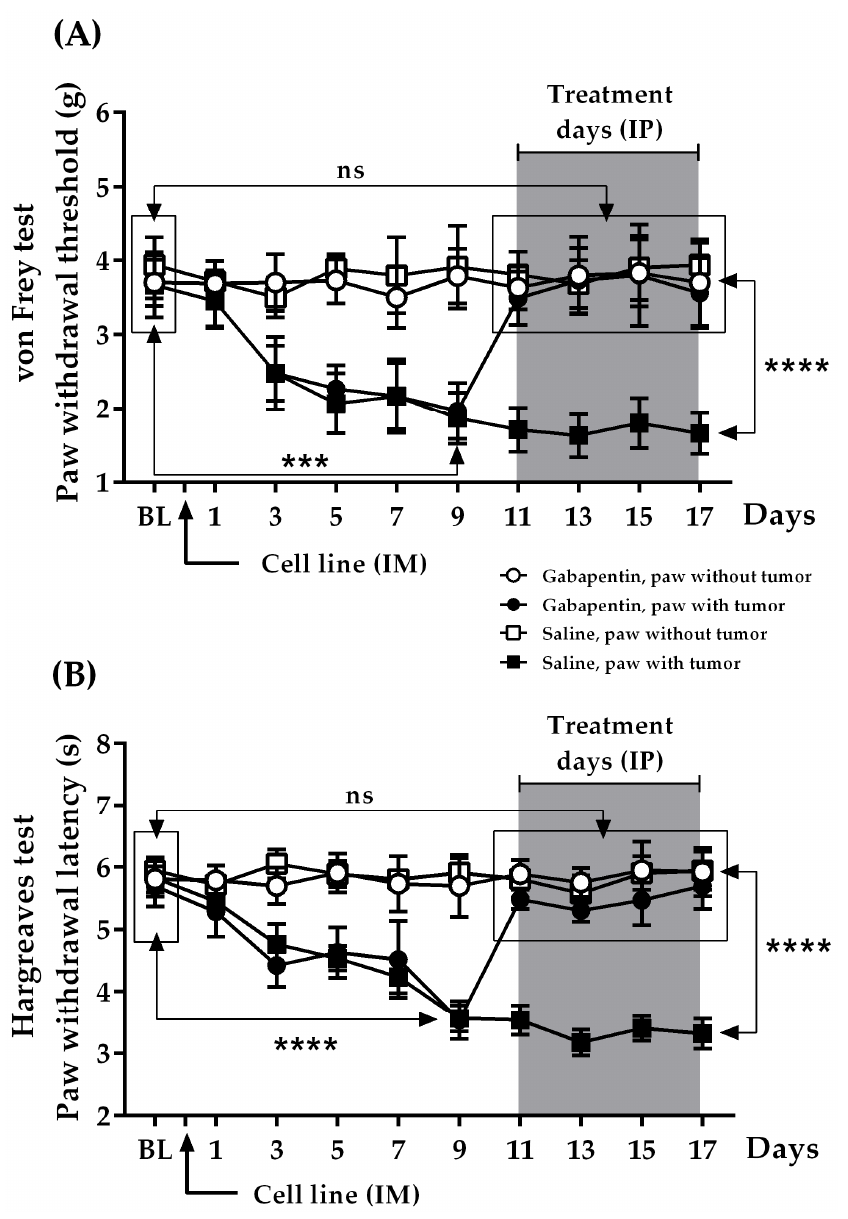
Figure 2. Therapeutic protocol: Gabapentin (100 mg/Kg) or saline was administered IP (days 11–17, grey box) to evaluate their effects on nociceptive responses caused by tumor progression: ( A ) von Frey test; ( B ) Hargreaves test. BL: Baseline (response value before IM inoculation of the cell line and before starting treatment). Contralateral non-inoculated limbs were used as internal controls. ns: non-significant. *** p ≤ 0.0002, **** p ≤ 0.0001, n = 10 mice/group. Each point represents the mean ± SEM of the sample.